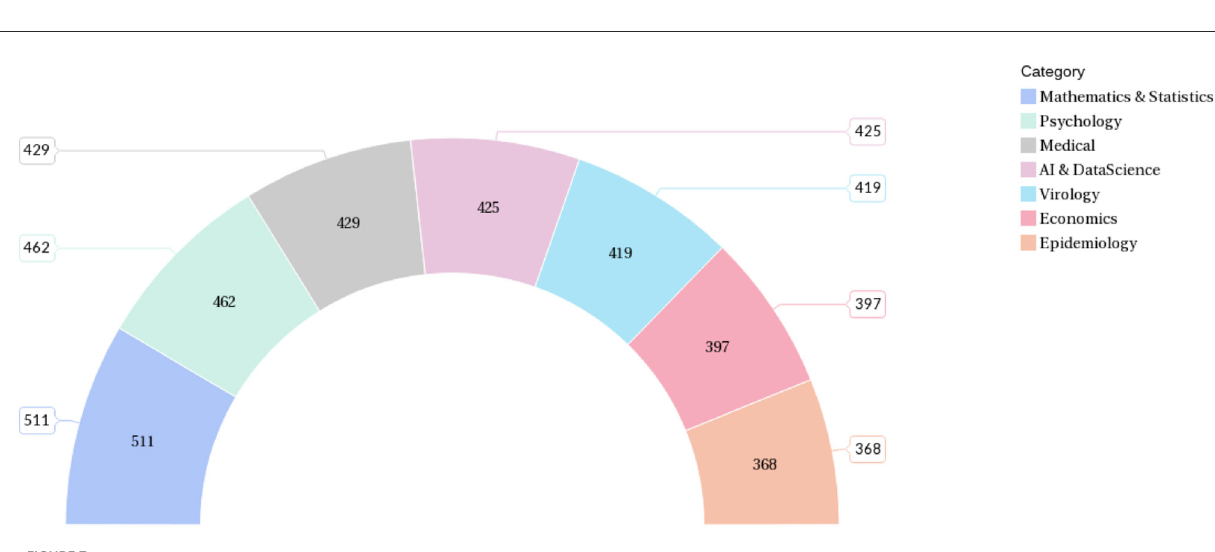
Bi-LSTM exploits the information about the sequence in both directions at every timestamp by connecting two hidden layers to the same output. The management of the past and